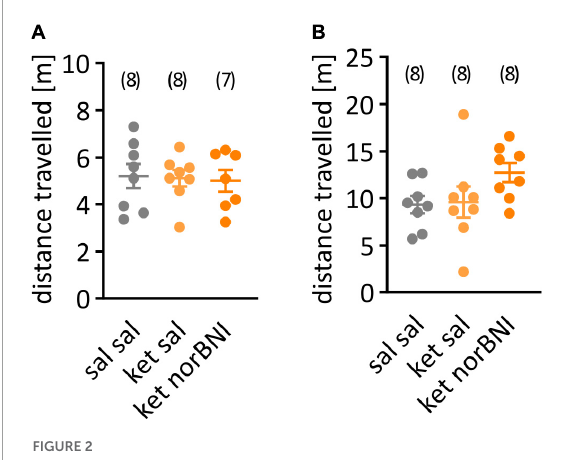
FIGURE2 Locomotor activity during the habituation to the partition and open field tests. (A) Distance traveled during the habituation to the partition apparatus. (B) Activity during habituation to the open field. The group that received only saline is labeled “Sal sal”, ketamine followed by saline “ket sal”, and ketamine followed by norbinaltorphimine “ket norBNI”. Each dot represents an individual mouse. The bar and whiskers correspond to mean and SEM respectively. Group sizes are indicated above the graph.